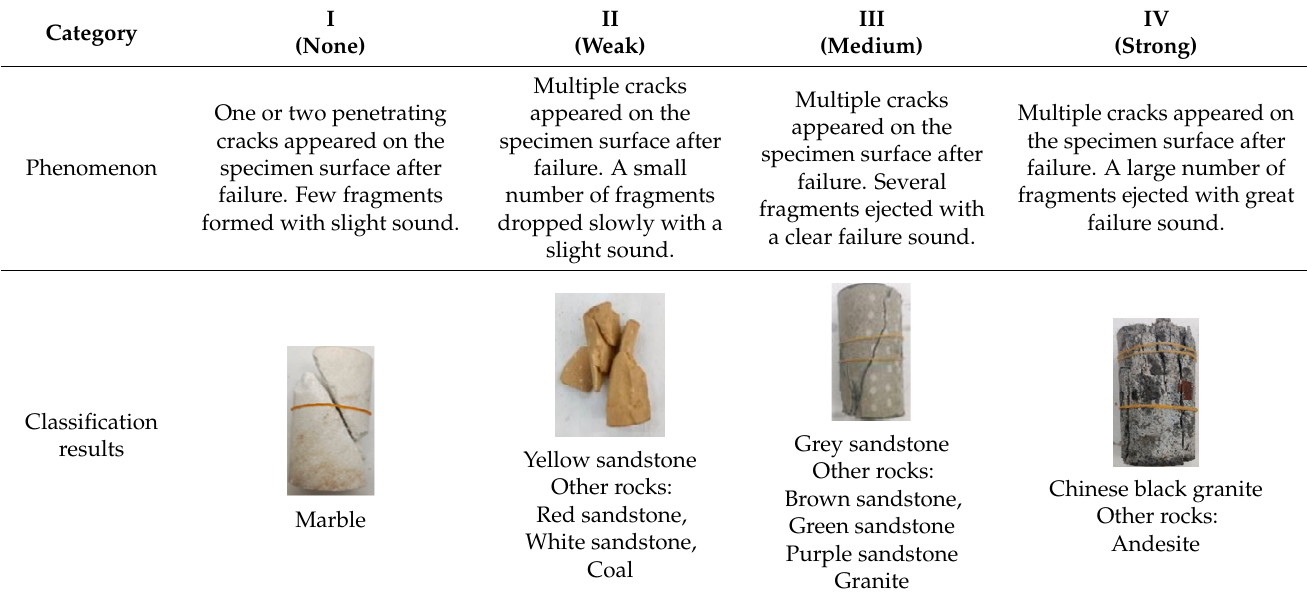
Table 6. Rockburst classification criterion based on the failure phenomena of hard rocks.